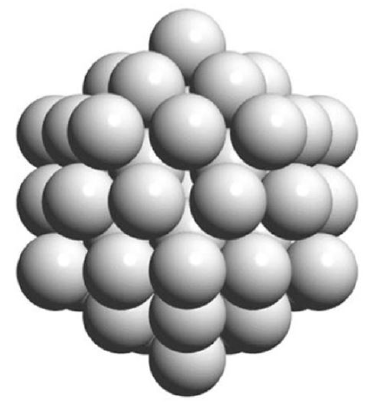
Figure 4. Scheme of the icosahedral shaped gold cluster Au 55 . Graphic taken as a cutout from Figure 7 in T. Mori and T. Hegmann [42] under permission of the Creative Commons Attribution 4.0 International License (http://creativecommons.org/licenses/by/4.0/).